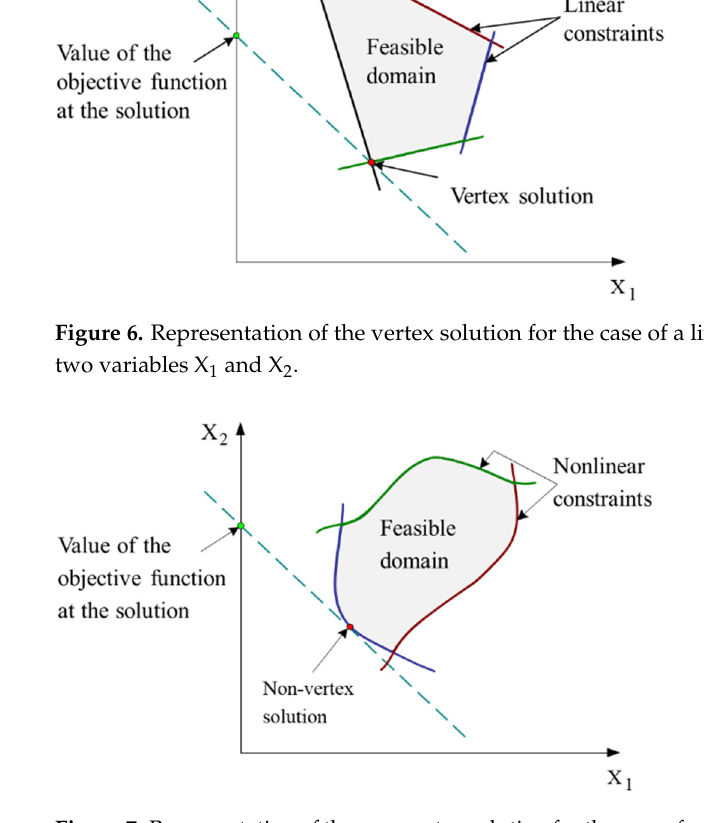
Figure 7. Representation of the non-vertex solution for the case of a nonlinear programming involving the two variables X 1 and X 2.